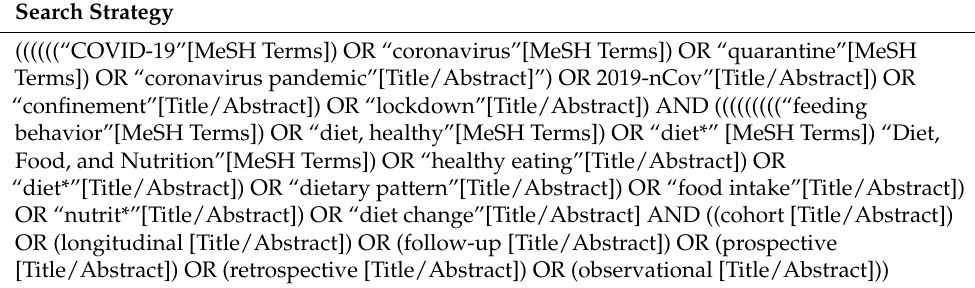
Table 2. Search Strategy in